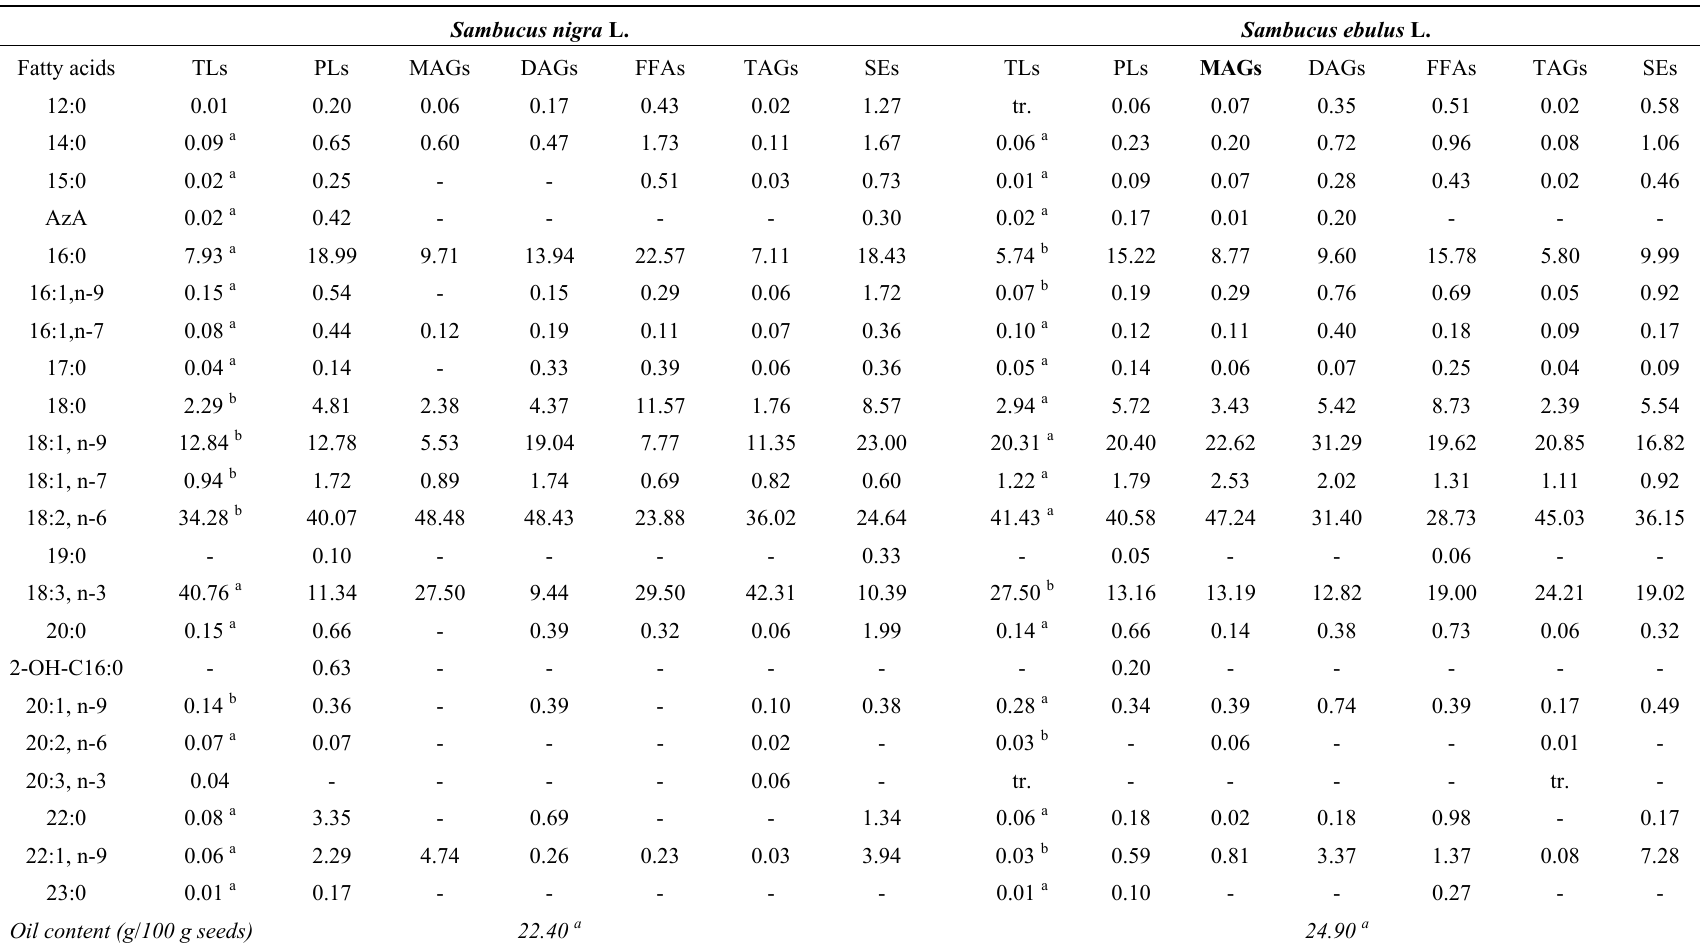
The values represent the means of three samples, analyzed individually in triplicate (n = 3 × 3). TLs: total lipids, PLs: polar lipids, MAGs: monoacylglycerols, DAGs: diacylglycerols, FFAs: free fatty acids, TAGs: triacylglycerols, SEs: sterol esters, tr.: trace. Different superscript letters ( a,b ) in the same row mean significant differences between TLs of the two species